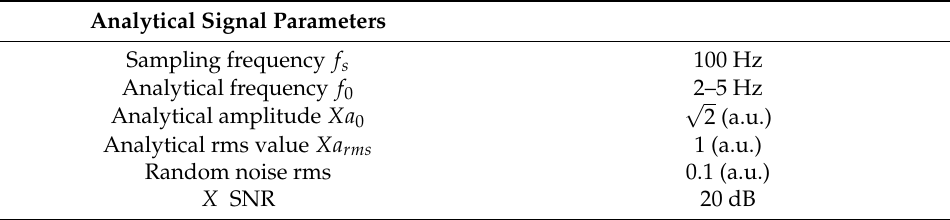
Table 1. Reference analytical signal